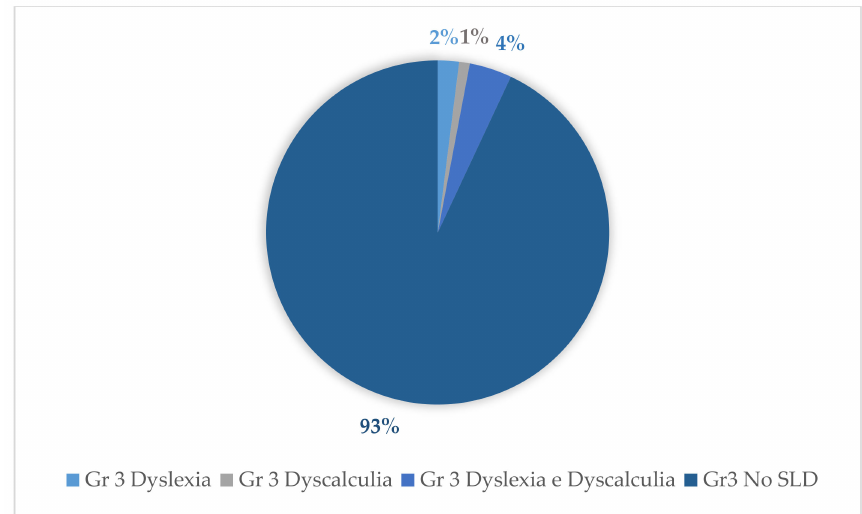
Figure 6. Percentages of SLD in group